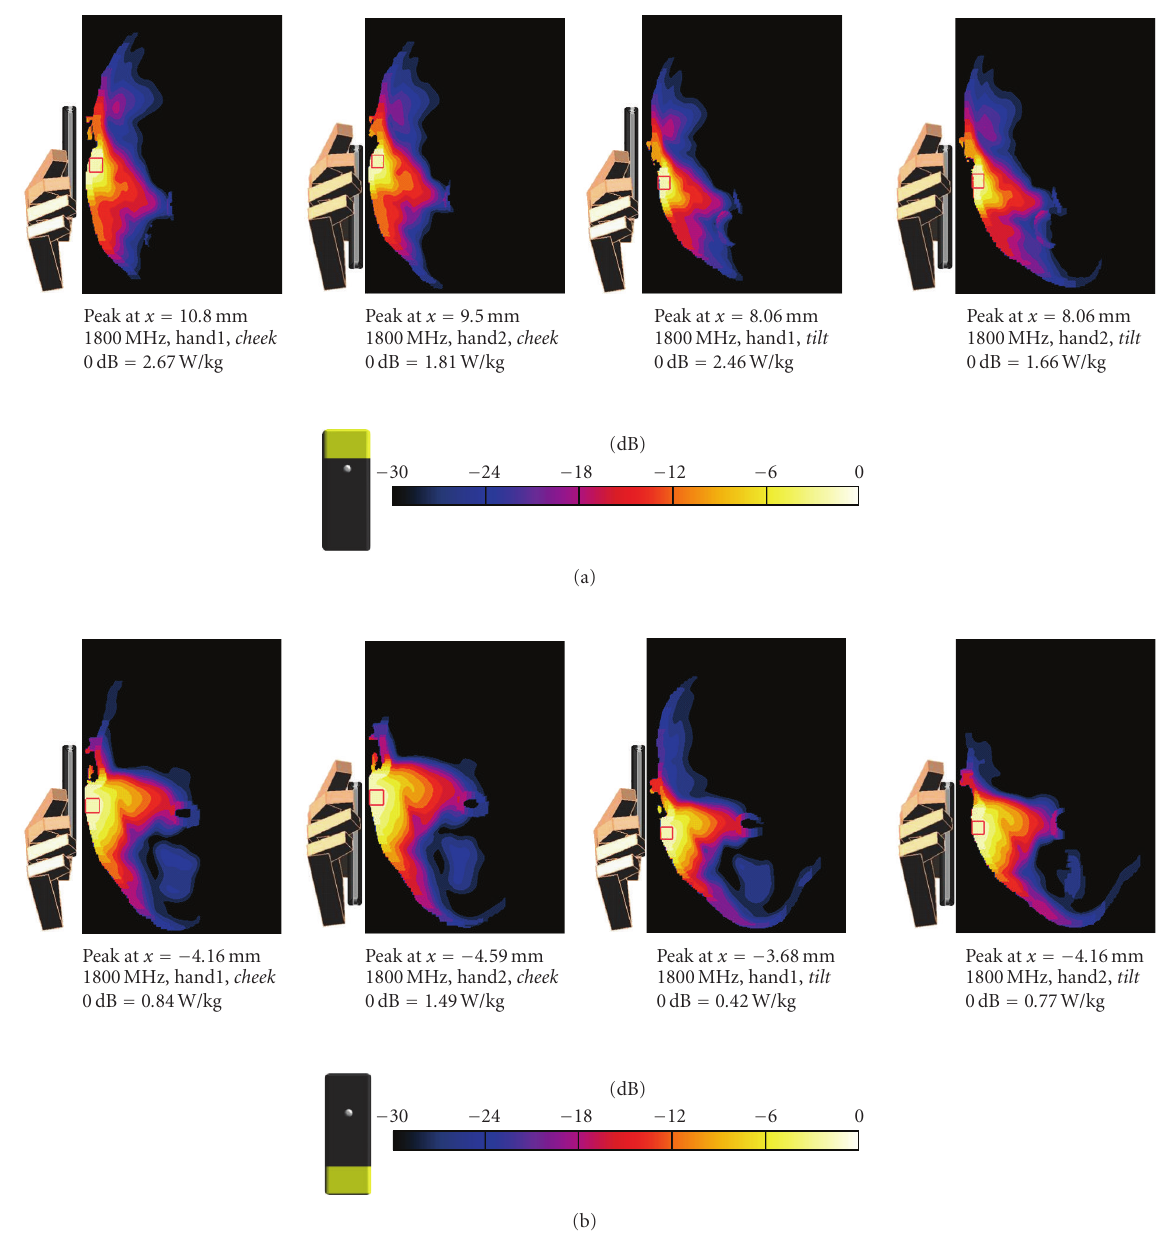
Figure 10: Sliced distribution of the averaged-peak SAR 1g in the yz -plane, normalized to 0.125 W input power, of the HR-EFH at di ff erent positions due to the exposure at 1800 MHz of (a) handset model-B1 and (b) handset